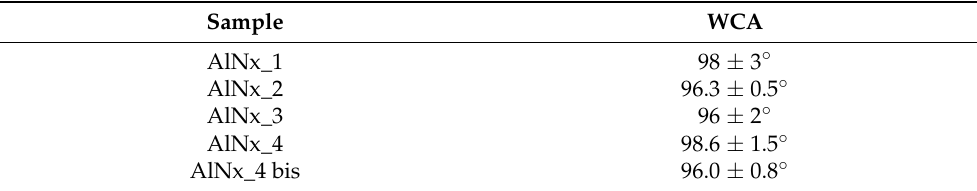
Figure 8. UV-VIS-NIR transmittance of aluminum nitride thin films compared to alumina. Table 3. WCA of oxygen-doped aluminum nitride thin